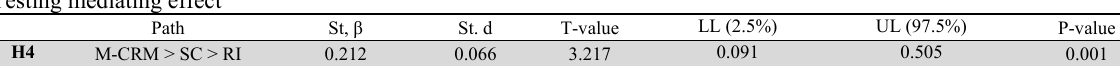
Testing mediating